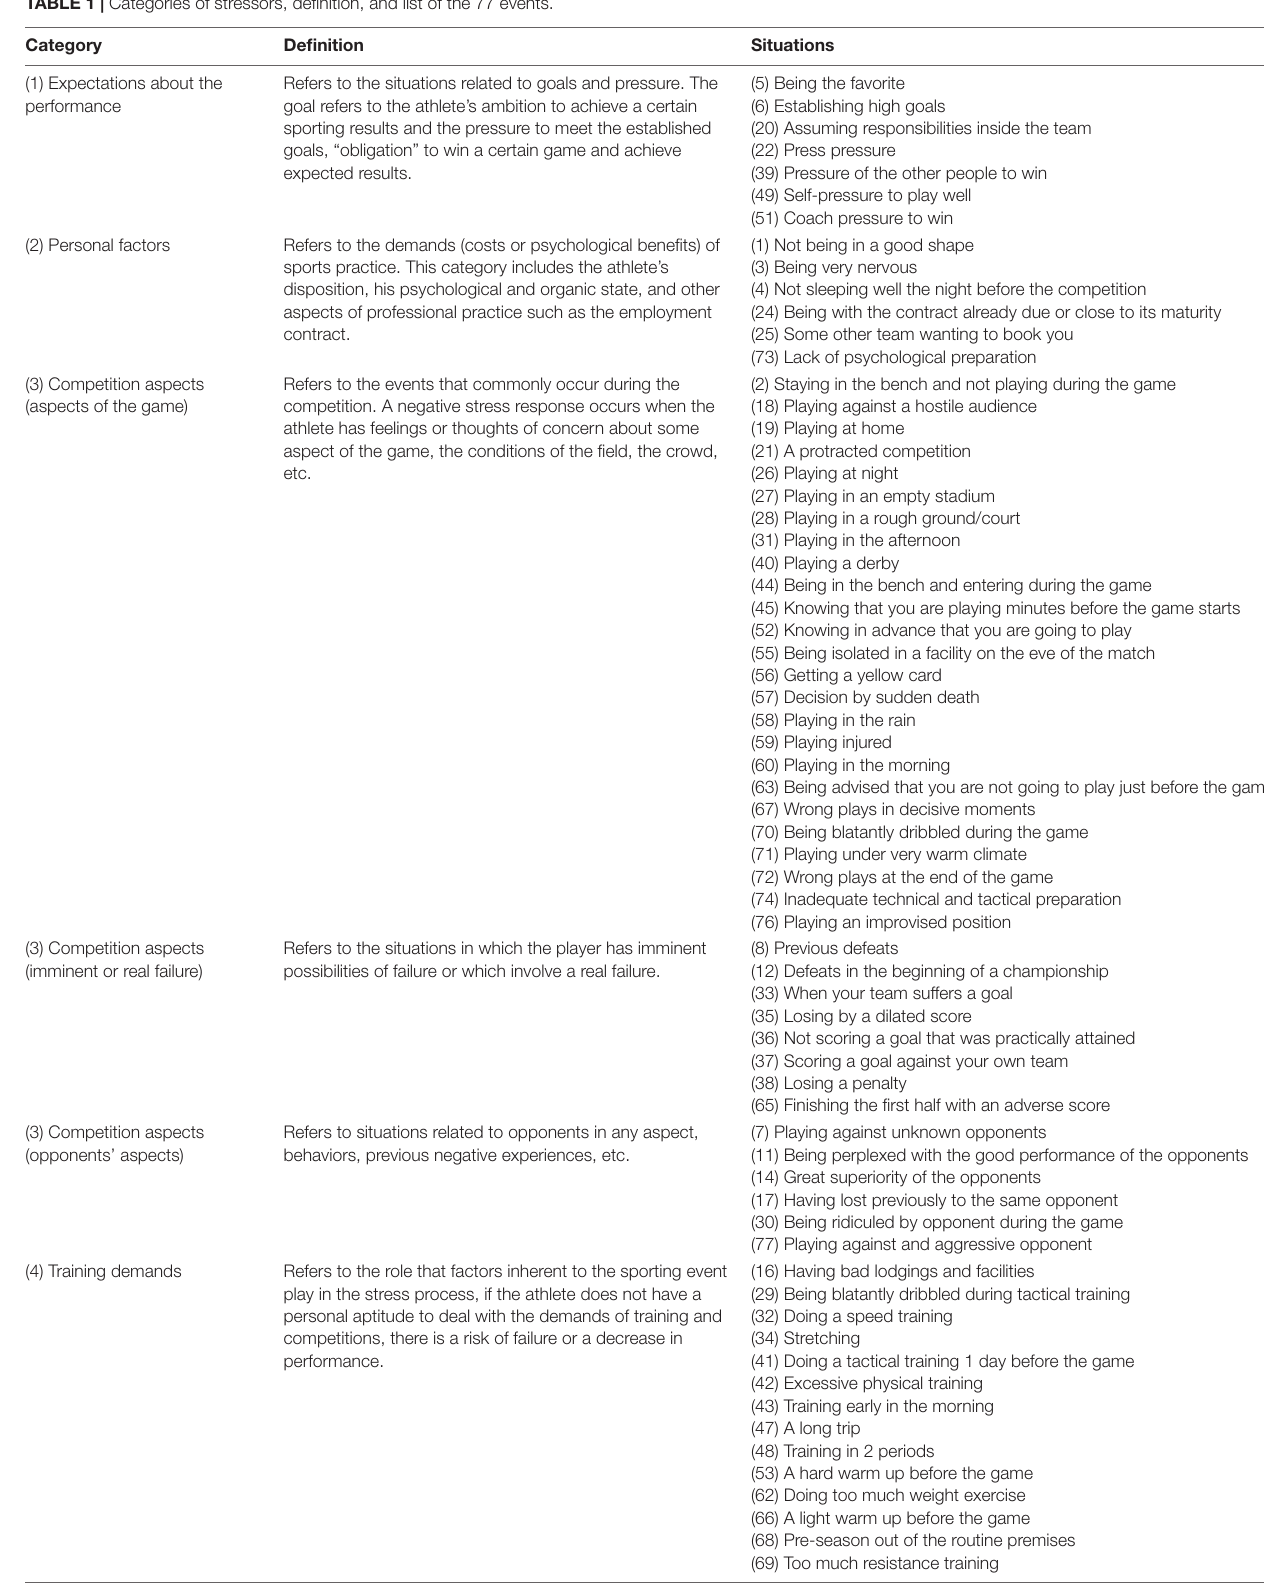
TABLE 1 | Categories of stressors, definition, and list of the 77